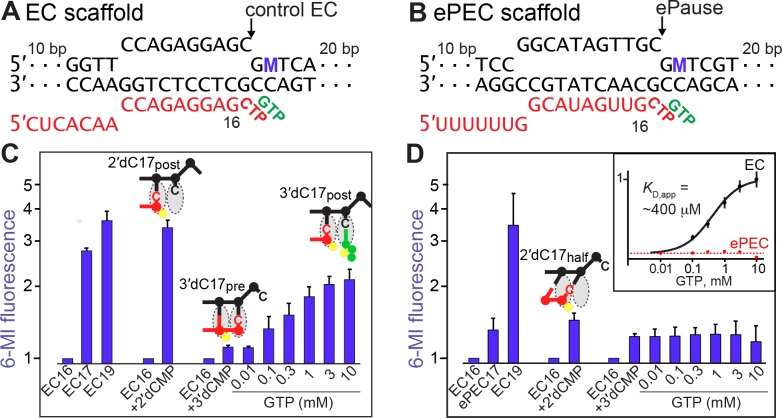
Translocation of the incoming template DNA limits elemental pause escape.(A and B) Scaffolds used to reconstitute control EC and ePEC for fluorescence experiments. M, position of 6-MI. (C and D) Equilibrium fluorescence changes of control EC and ePEC, respectively, upon reaction with NTP or NTP analog or binding of GTP to 3′deoxyC-containing complexes. RNA extension was verified by quantifying radiolabeled RNAs (see Figure 3—figure supplement 2). Inset, GTP-binding curve fit for the 3′dC17 EC (black line) and the 3′dC-ePEC (dotted red line; no binding evident). Error bars are SD of triplicate measurements.